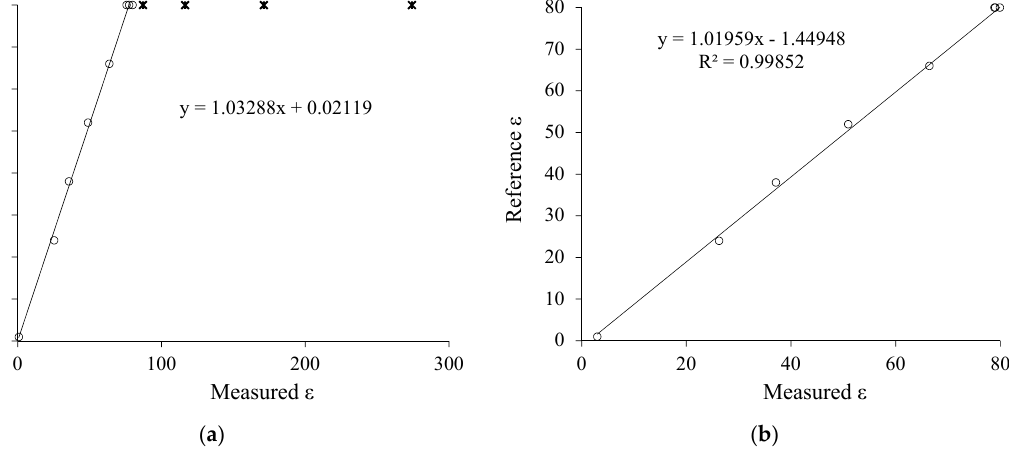
Figure 8. ( a ) Approximation method to estimate ε ; ( b ) real-dual-frequency method to estimate ε .